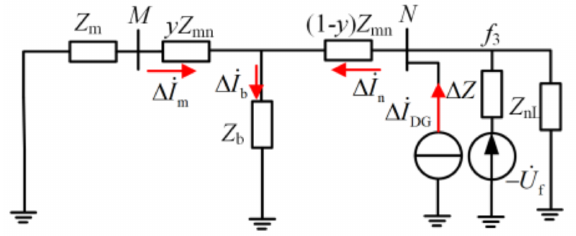
Figure 9. Composite sequence network of the positive-sequence fault component: the UBL is downstream of the fault point in case of an external fault.